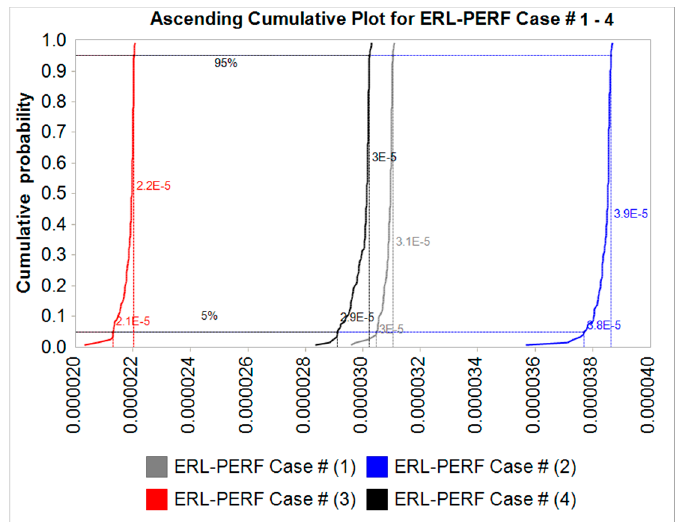
Figure 14. ERL Cumulative distribution plots—Performance solutions Case #1 to #4.